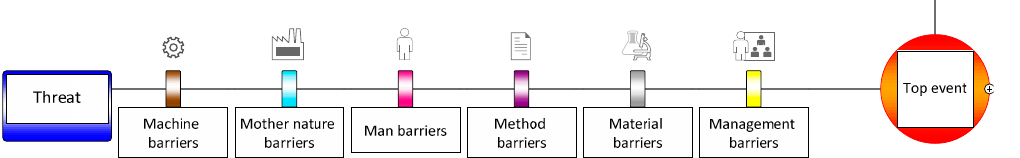
Figure 7. Threat path with coloured barrier categories.